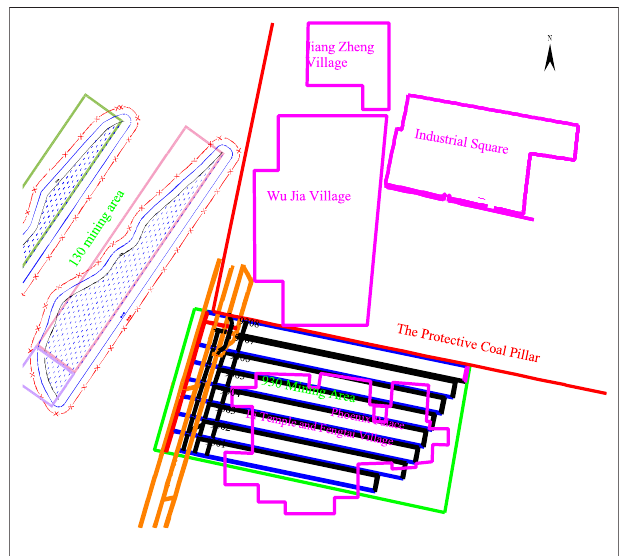
FIGURE 13 | Distribution of the 930 mining